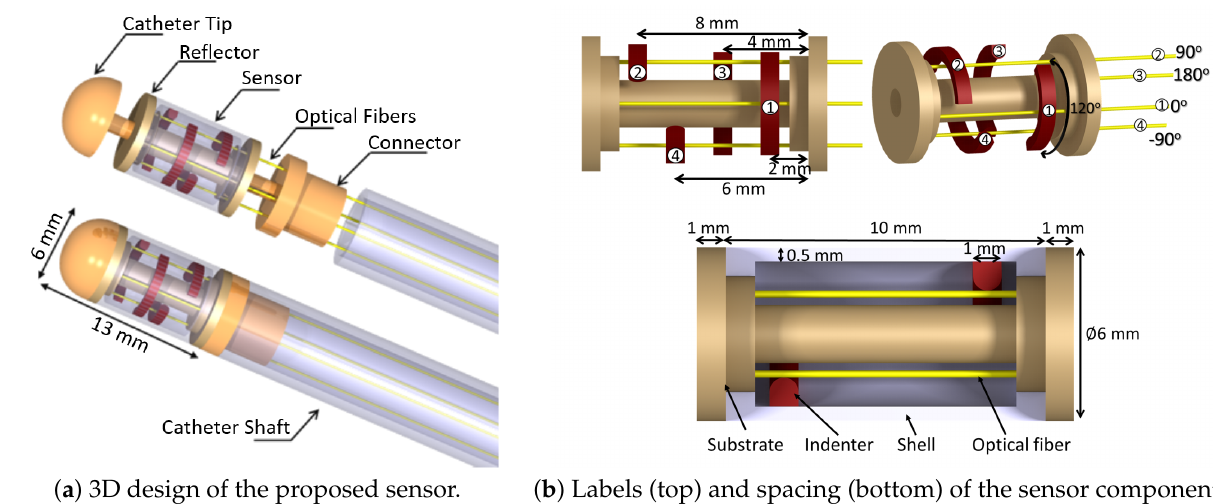
Figure 2. ( a ) Conceptual integration of the proposed sensor on a TAVI catheter, ( b ) cross-sectional view of the proposed sensor with the view of the flexible shell, indenters, substrate and the optical